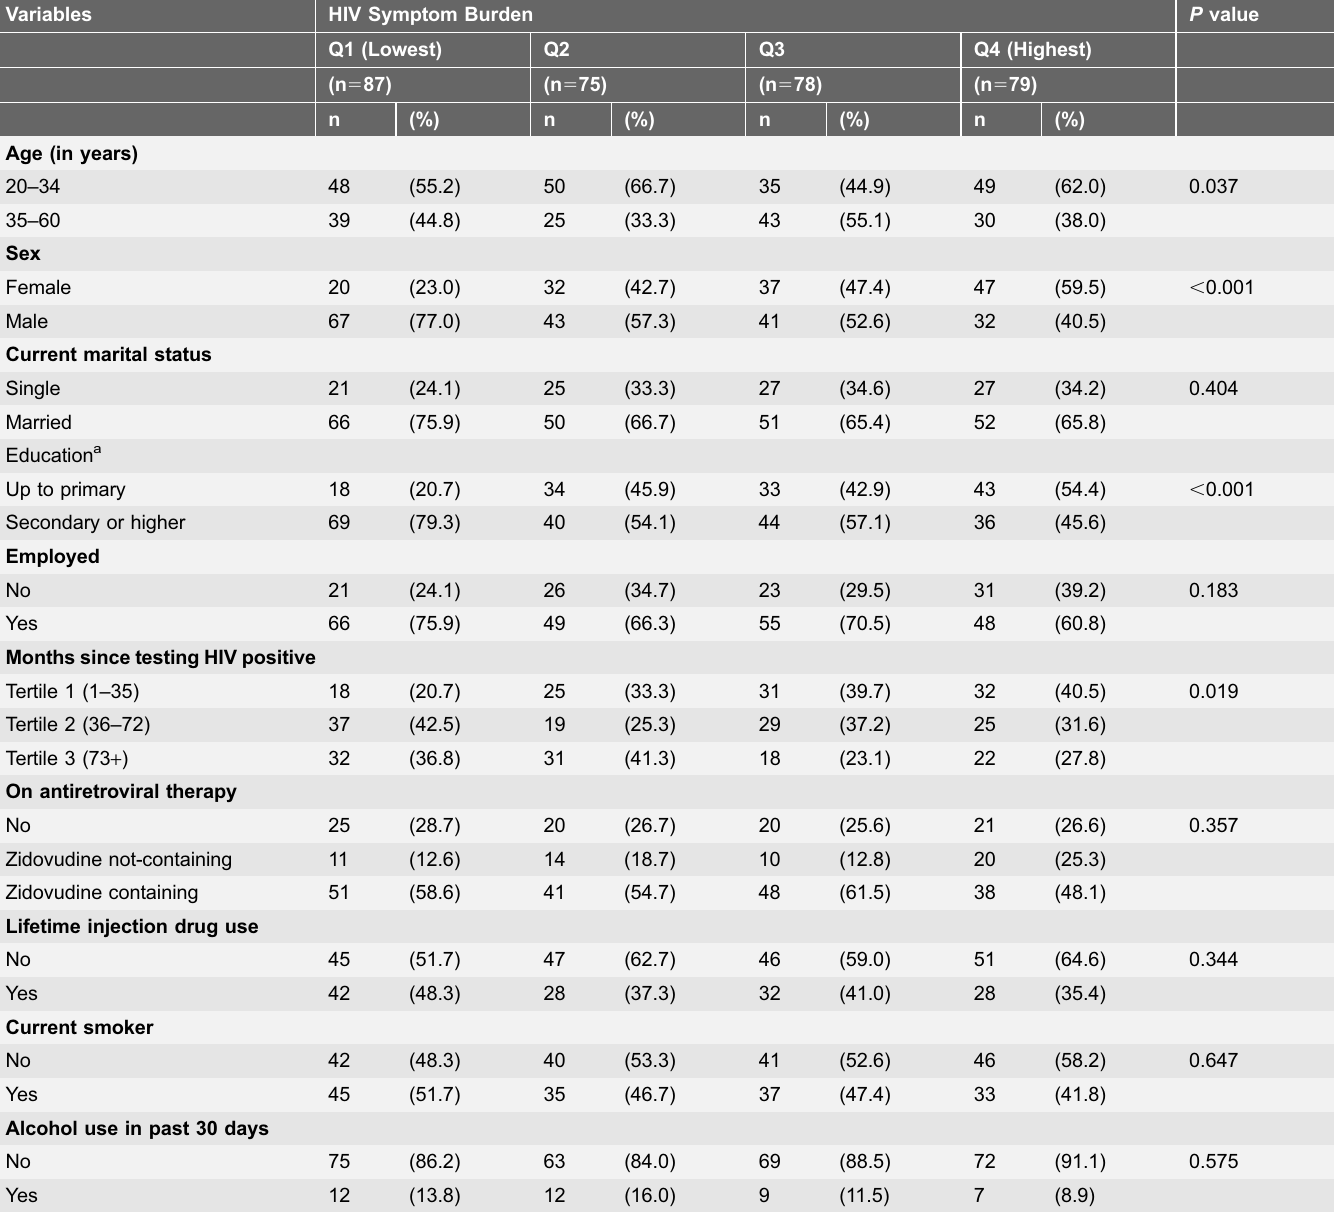
Table 1. Socio-demographic and health characteristic of participants according to quartile of HIV symptom burden (n 5